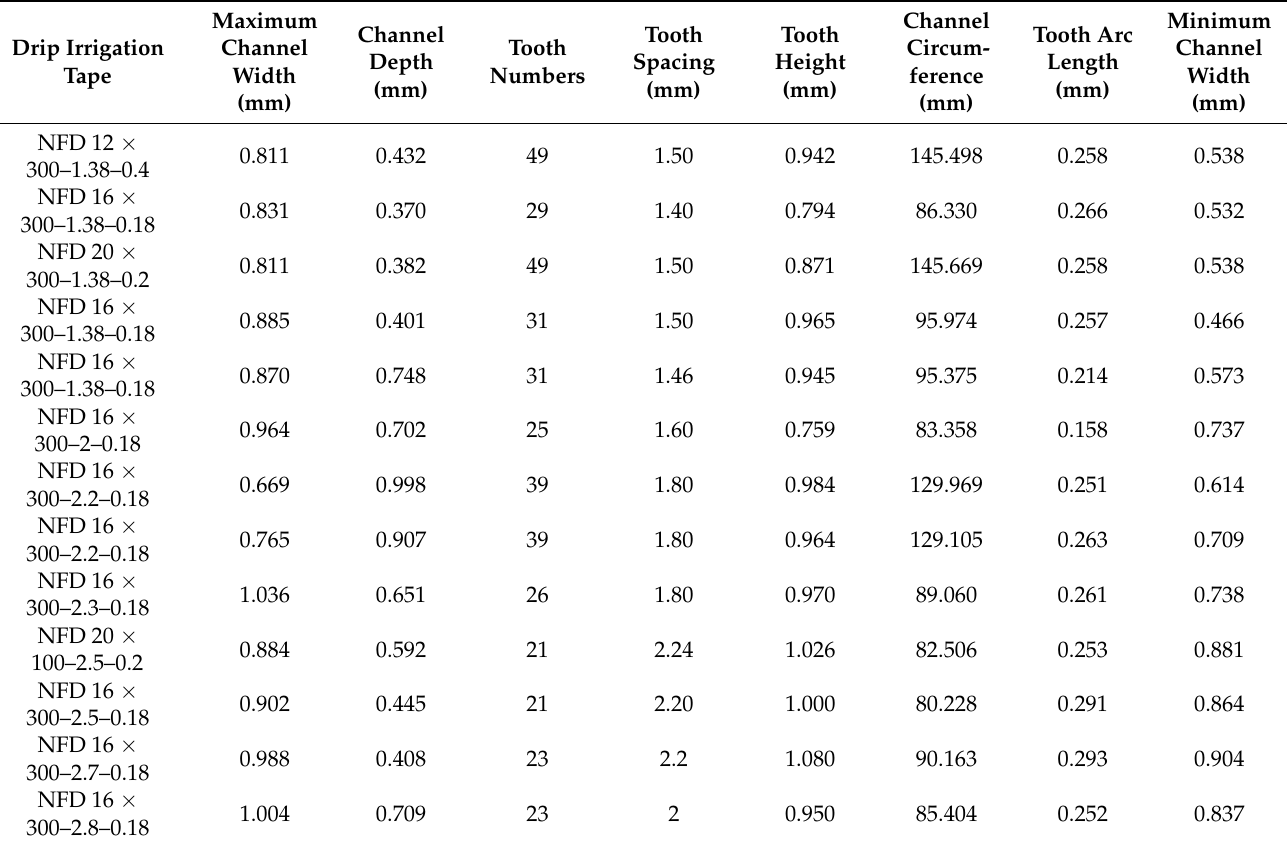
Table 1. Product parameters of the emitter of the drip irrigation tape